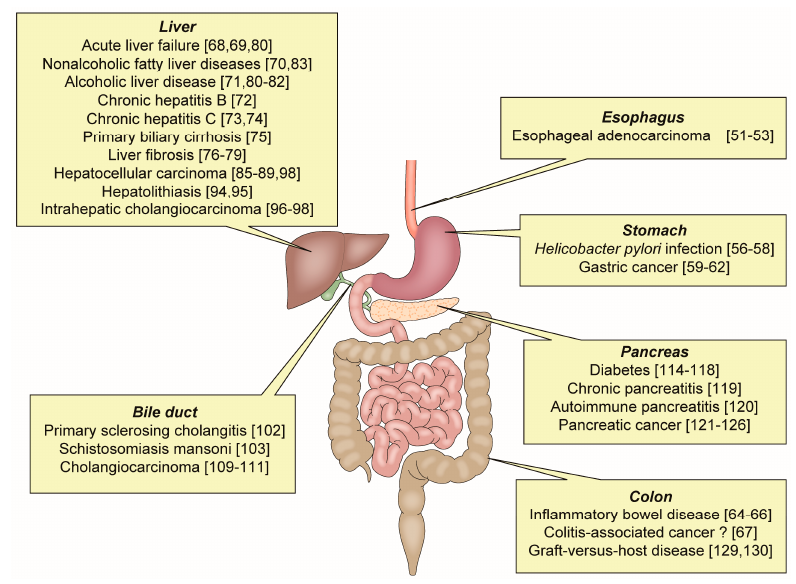
Figure 2. Inflammatory gastrointestinal and liver diseases related to osteopontin.